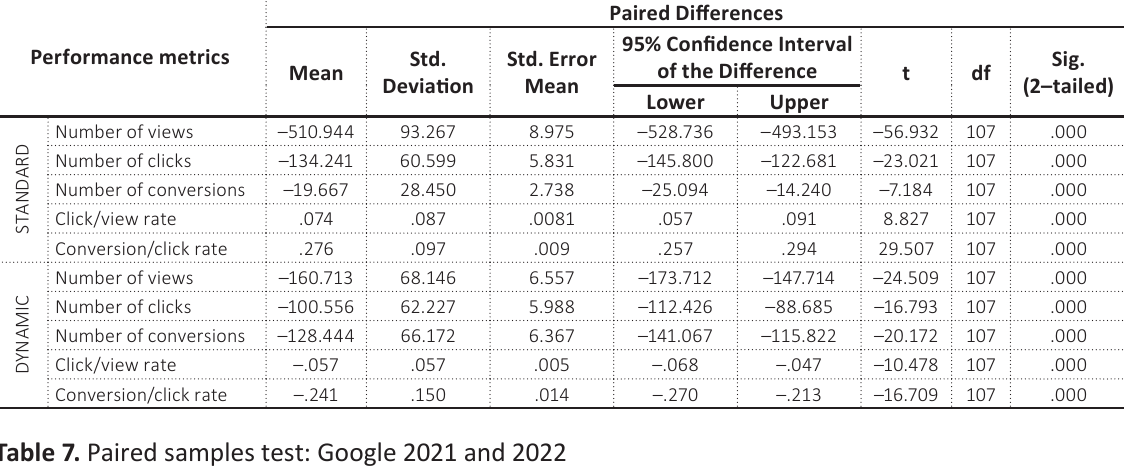
Table 7. Paired samples test: Google 2021 and 2022 Performance